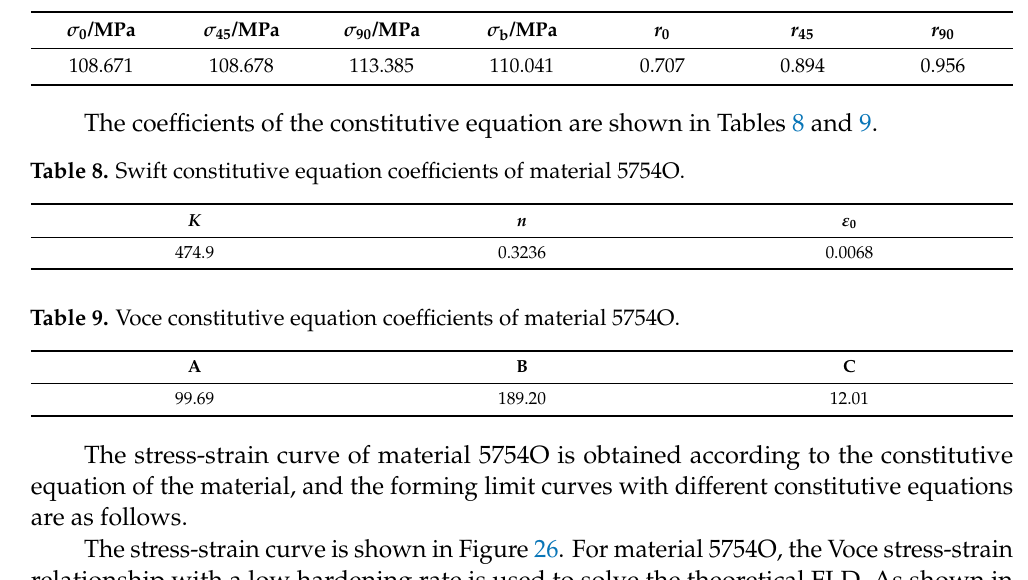
instability criterion.